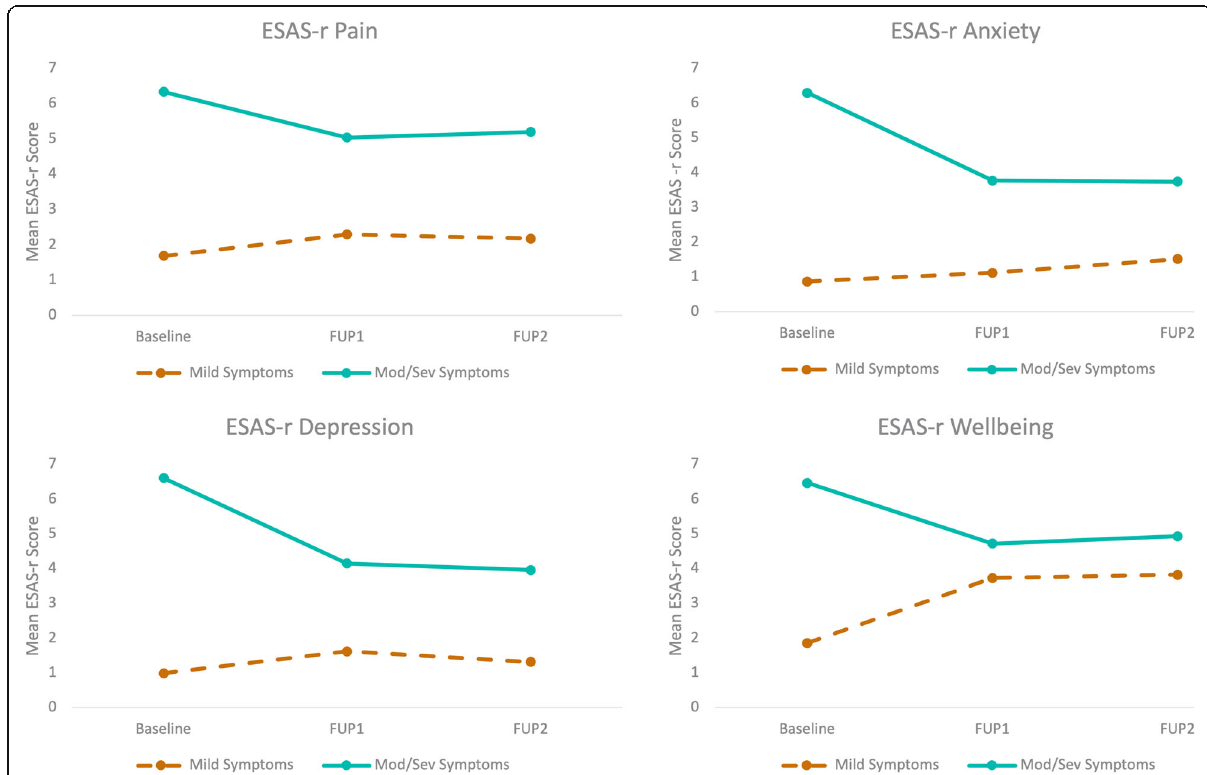
Fig. 2 CBD-rich treatment effect according to symptom severity: mild or moderate/severe in 279 patients. FUP1, follow-up visit at 3 month; FUP2, follow-up visit at 6 month. a Mean ESAS-r scores for the pain symptom, b mean ESAS-r scores for the anxiety symptom, c mean ESAS-r scores for the depression symptom, and d mean ESAS-r scores for overall wellbeing. According to mixed ANOVAs, patients with moderate/severe symptoms reported symptom reduction whereas patients with mild symptoms reported symptom deterioration from baseline to FUP1. No effect was statistically significant between FUP1 and